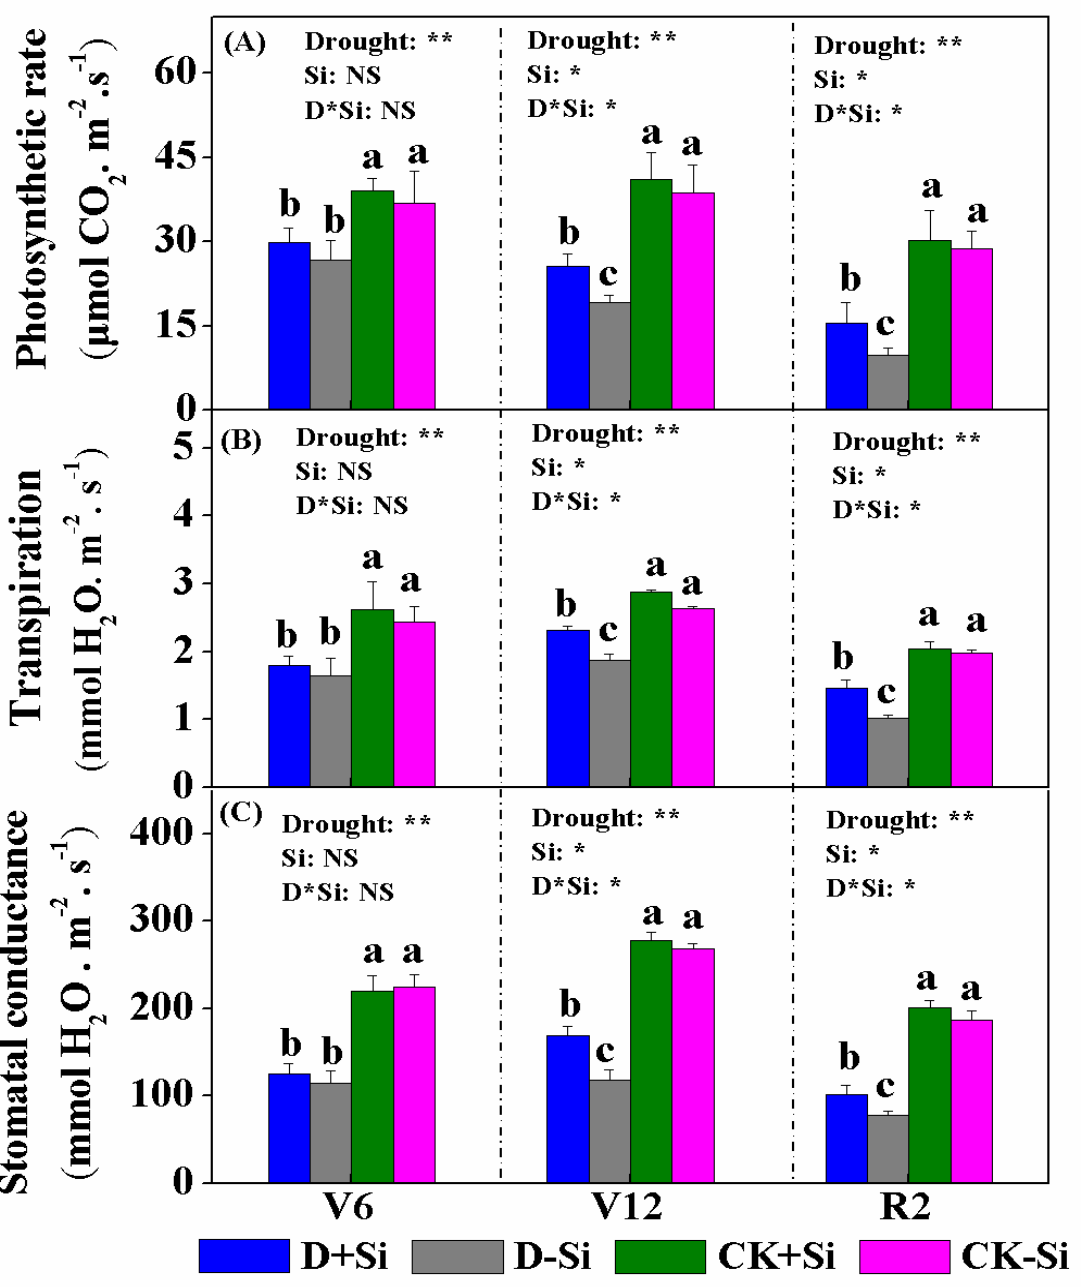
Figure 3. E ff ect of Si application on photosynthetic rate (Pn, A ), stomatal conductance (Sc, B ), and transpiration (Tr, C ) of maize at the V6, V12, and R2 stages under drought and control conditions. V6, the 6-leaf stage; V12, the 12-leaf stage; R2, the blister stage; + Si, Si addition; -Si, no Si addition; D, drought stress; CK, well-watered control conditions. Data are means ± standard errors (SE) of three replicates, where n = 3 for photosynthetic rate (Pn), stomatal conductance (Sc), and transpiration (Tr). Di ff erent letters (a, b, c) above the bars indicate statistical significance ( p ≤ 0.05). ** Significant at p ≤ 0.01; * significant at p ≤ 0.05; NS, no significant di ff